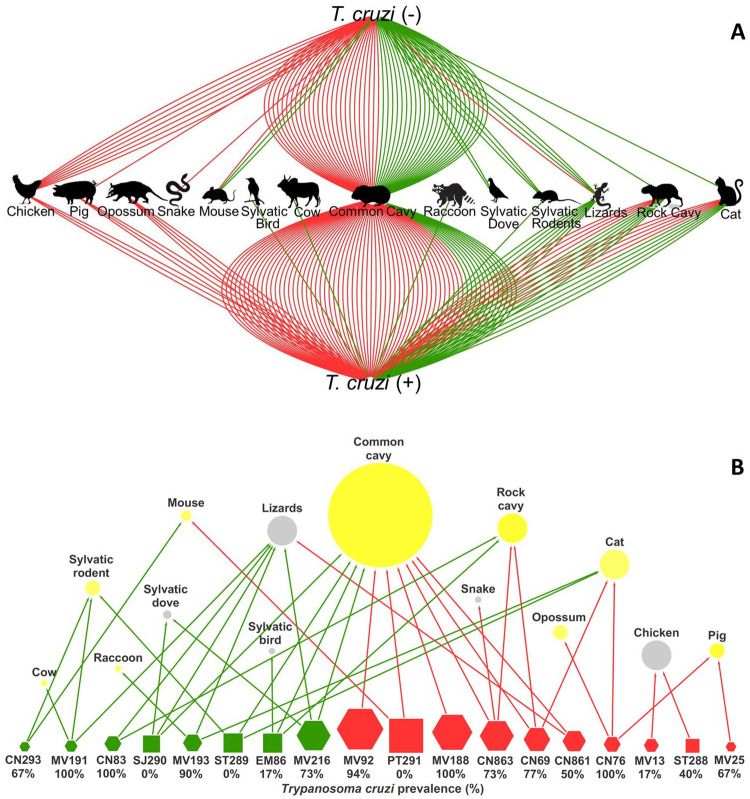
Overall food sources found for the 181 Triatoma brasiliensis.Connections (A) to the above pole represent food sources in insects infected by Trypanosoma cruzi and to the up pole non-infected insects. (B) illustrates the diversity of food sources per population, where T. cruzi refractory animals are in grey and potential reservoirs (mammals) are in yellow circles. Squares represent T. brasiliensis populations from Paraíba and hexagons the ones from Rio Grande do Norte State. For A and B the feeding sources found in the peridomestic population are in red lines/nodes and the sylvatic in green. The node sizes are proportional to the sampling size.